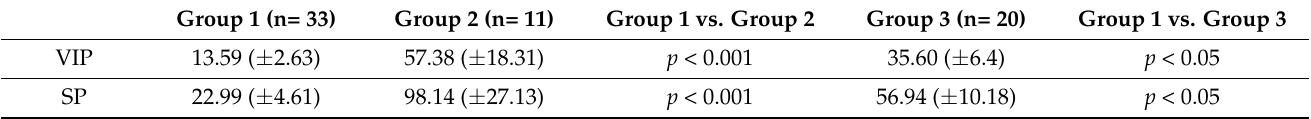
Table 2. Levels of SP and